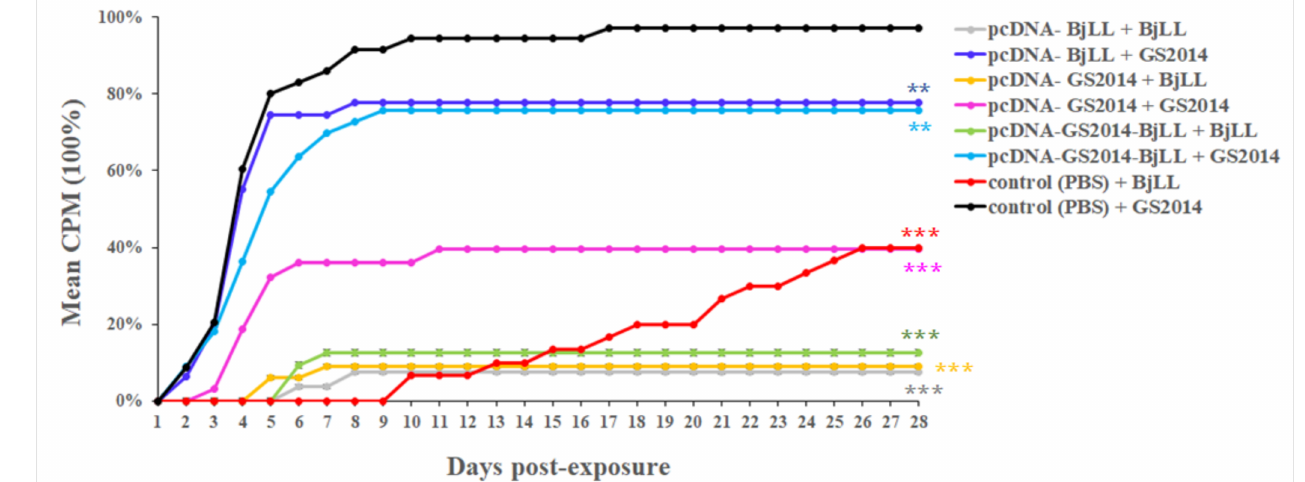
Figure 7. Mean cumulative mortality curves from the challenge experiments. At day 35 after immunization of DNA vaccines, rainbow trout were challenged with BjLL or GS2014 at dose of 10 5.8 TCID50/mL by batch immersion. The fish were monitored for 28 days postinfection (dpi), and cumulative percentage mortality (CPM) was calculated for all groups. The data of each group were compared with that of control (PBS) + GS2014 group. (** p < 0.05; *** p <